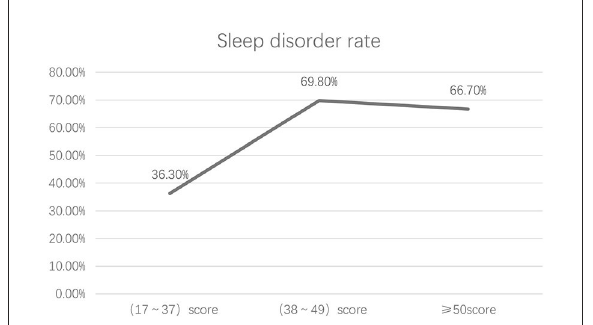
FIGURE2 Developing trend of the incidence of PTSD sleep disorders in varying degrees.